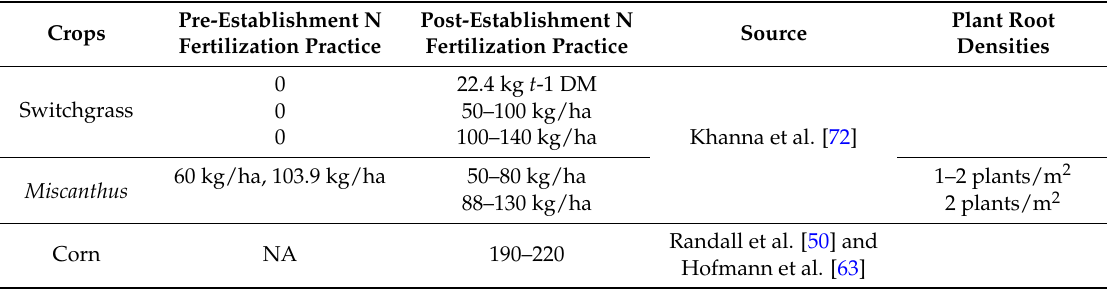
Table 4. Prevailing agronomy practices for bioenergy crops and potential nitrate